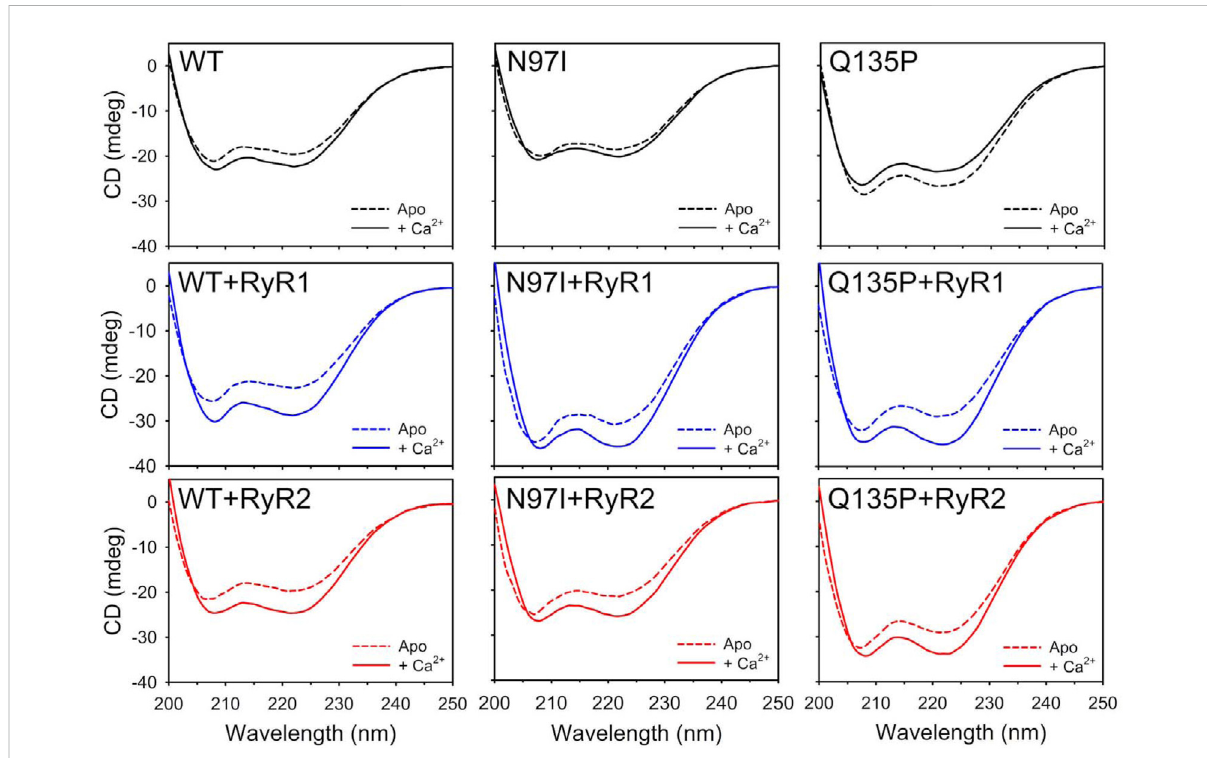
FIGURE 2 Investigation of secondary structure of CaM variants and their RyR1/2 peptide complexes. Far-UV CD spectra (200 – 250 nm) of 10 μ M CaM variants alone (top panels, black), and incubated with 20 μ M RyR1 (center panels, blue), or 20 μ M RyR2 (bottom panels, red), were collected in the presence of 300 µM EGTA (dashed lines) and after the addition of 600 µM Ca 2+ (300 µM free Ca 2+ , solid lines). The spectrum of sole buffer was considered as blank and subtracted; each curve represents the average of fi ve accumulations. Temperature was set at 25 °